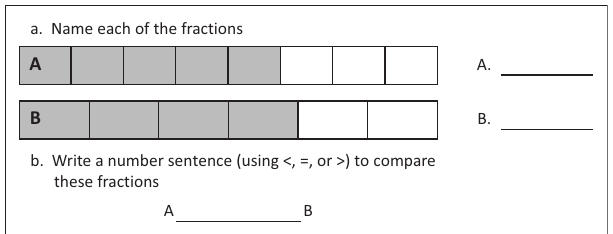
FIGURE 1: Example fraction task: What is being